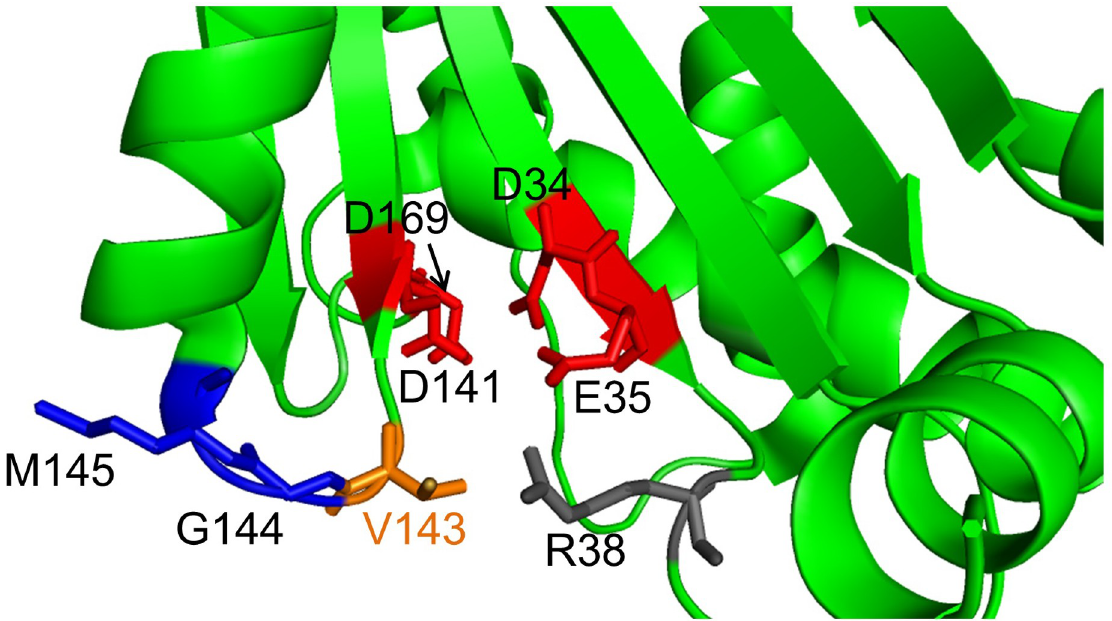
Fig 1. Close-up view of the active site of human RNase H2. The active site of human RNase H2 (PDB accession code 3PUF) [7] is shown. Val143, Asp169, and Arg38 are shown in orange, red, and gray, respectively, and Gly144 and Met145 are shown in blue.